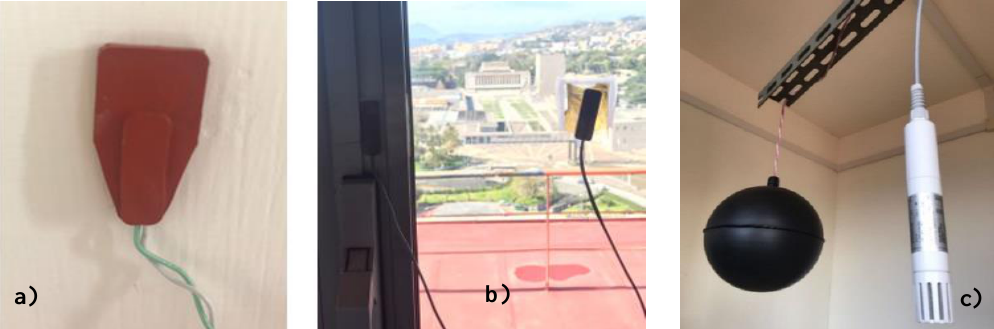
Figure 6. a ) Thermohygrometer in a solar radiation shield. Pyranometers: b ) side and c ) bottom views. All the above described sensors (except Testo 174H devices) were connected to a Compact Rio NI 9146 data logger (Figure 7), linked through an Ethernet cable to a suitable dedicated PC. Note that the Testo 174 H data loggers were synchronized to the Compact Rio in order to obtain simultaneous